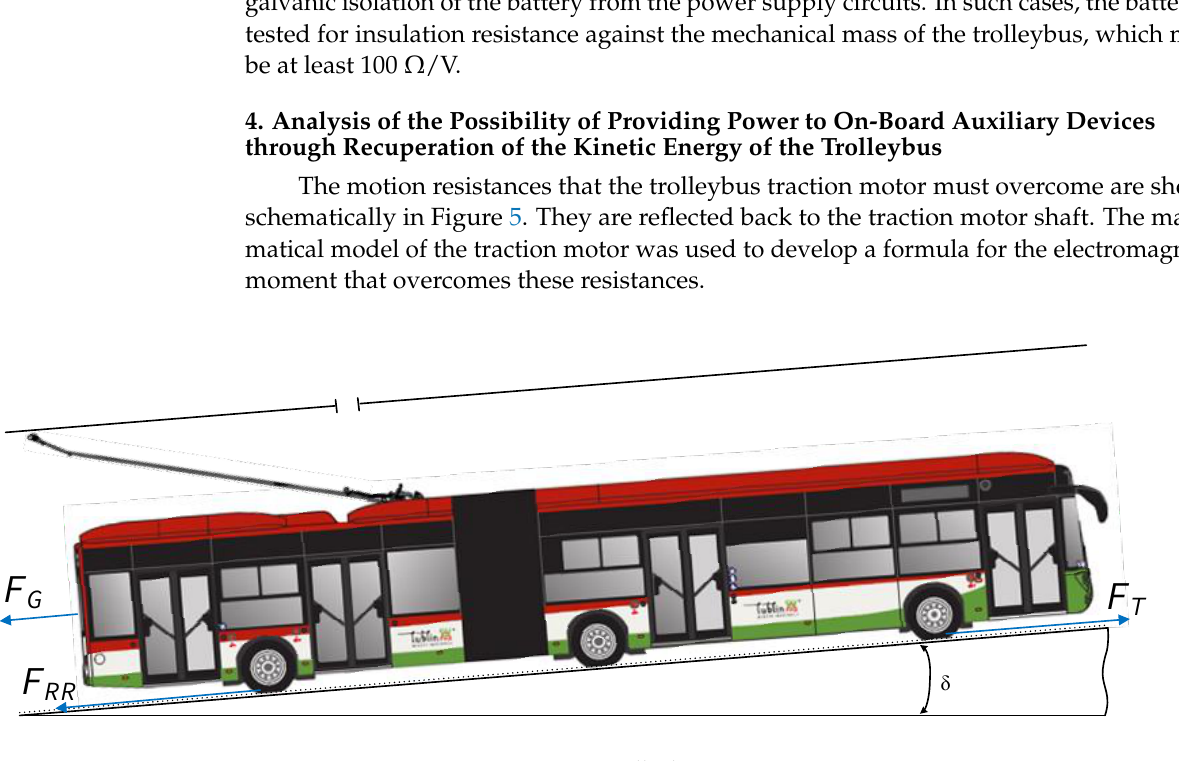
Figure 5. Forces acting on a trolleybus in motion.